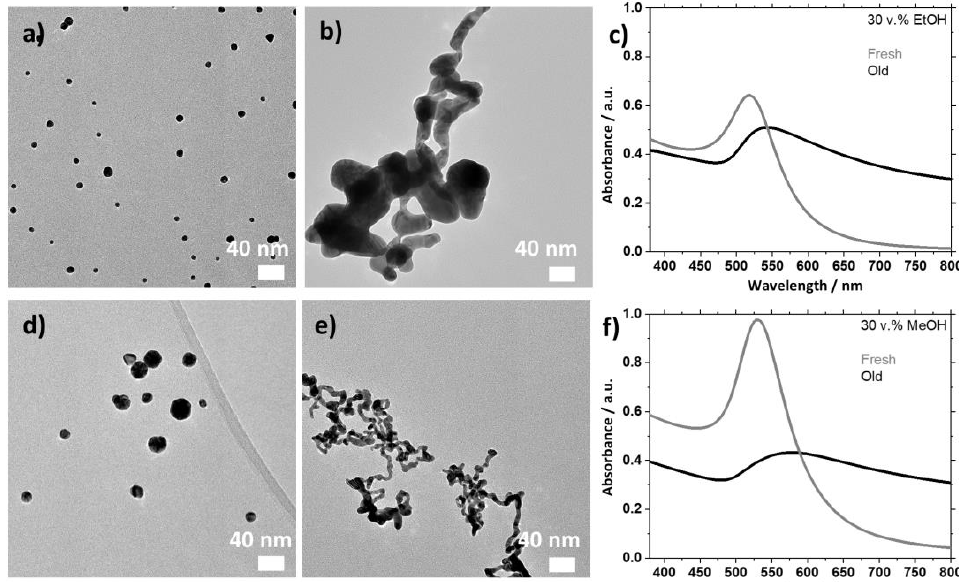
Figure 2. Characterization of Au NMs obtained by a surfactant-free RT synthesis using 30 v.% ( a – c ) EtOH and ( d – f ) MeOH as reducing agent. ( a – e ) TEM of samples prepared using ( a , d ) a fresh or ( b , e ) an old stock solution of NaOH and ( c , f ) UV-vis characterization of the samples, as indicated.